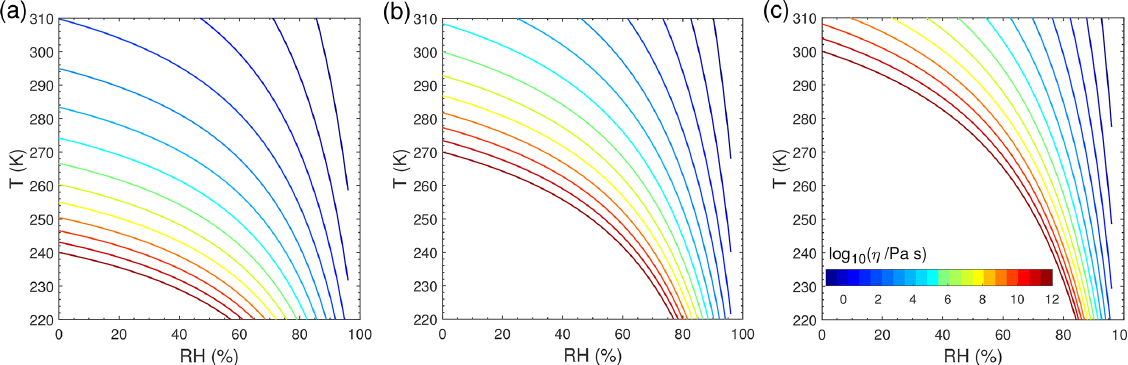
Figure 1. Viscosity of preexisting particles as a function of temperature and relative humidity. The glass transition temperatures under dry conditions ( T g , org ) are (a) 240K, (b) 270K, and (c)